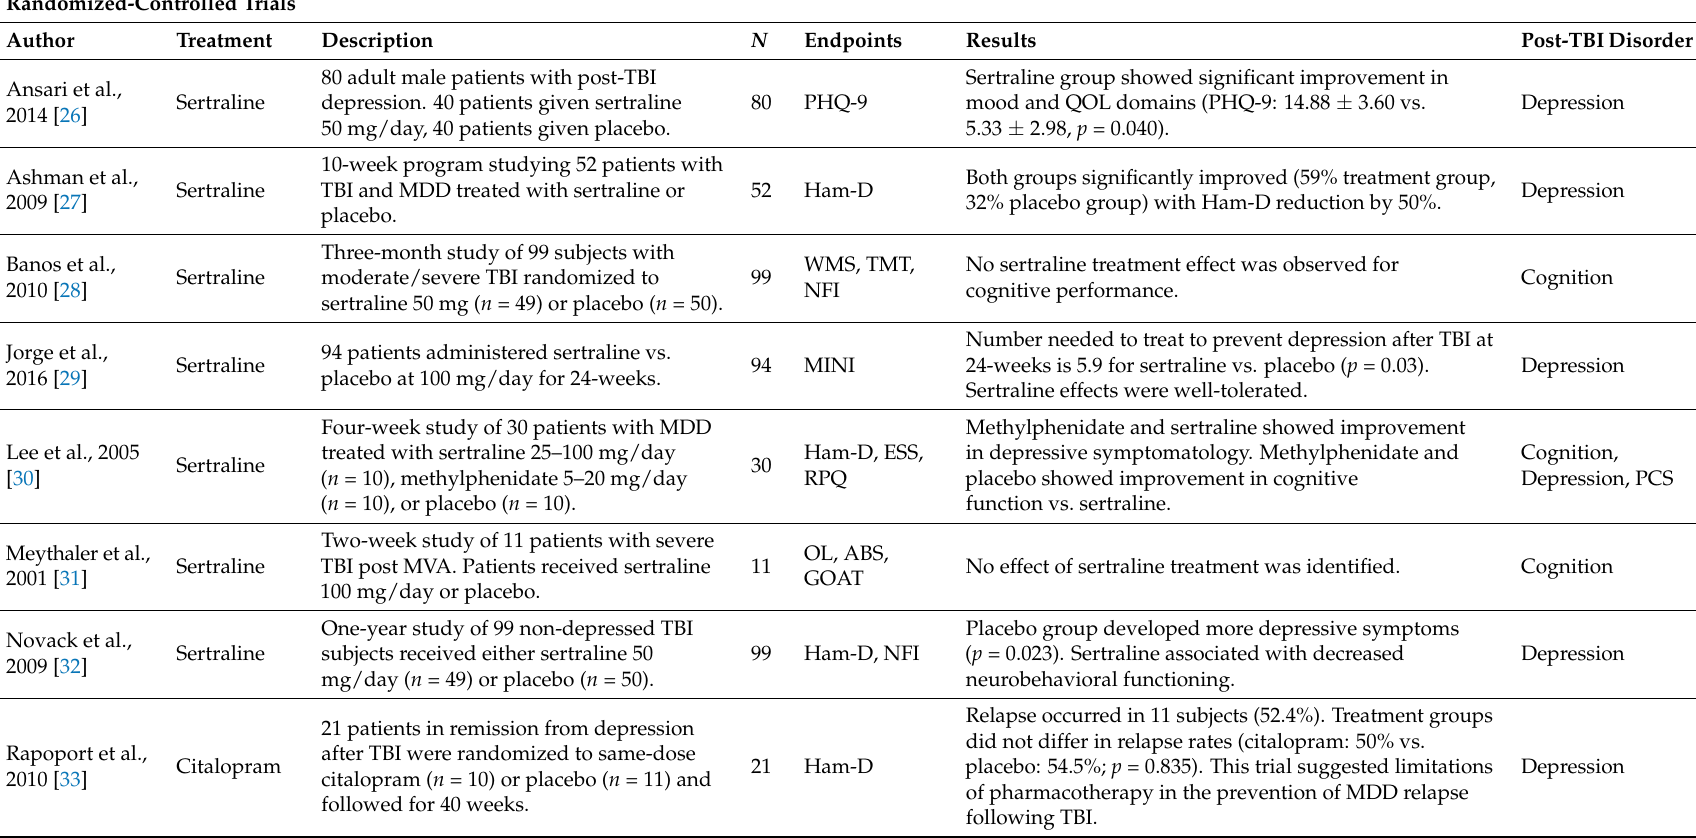
Table 1. Summary of